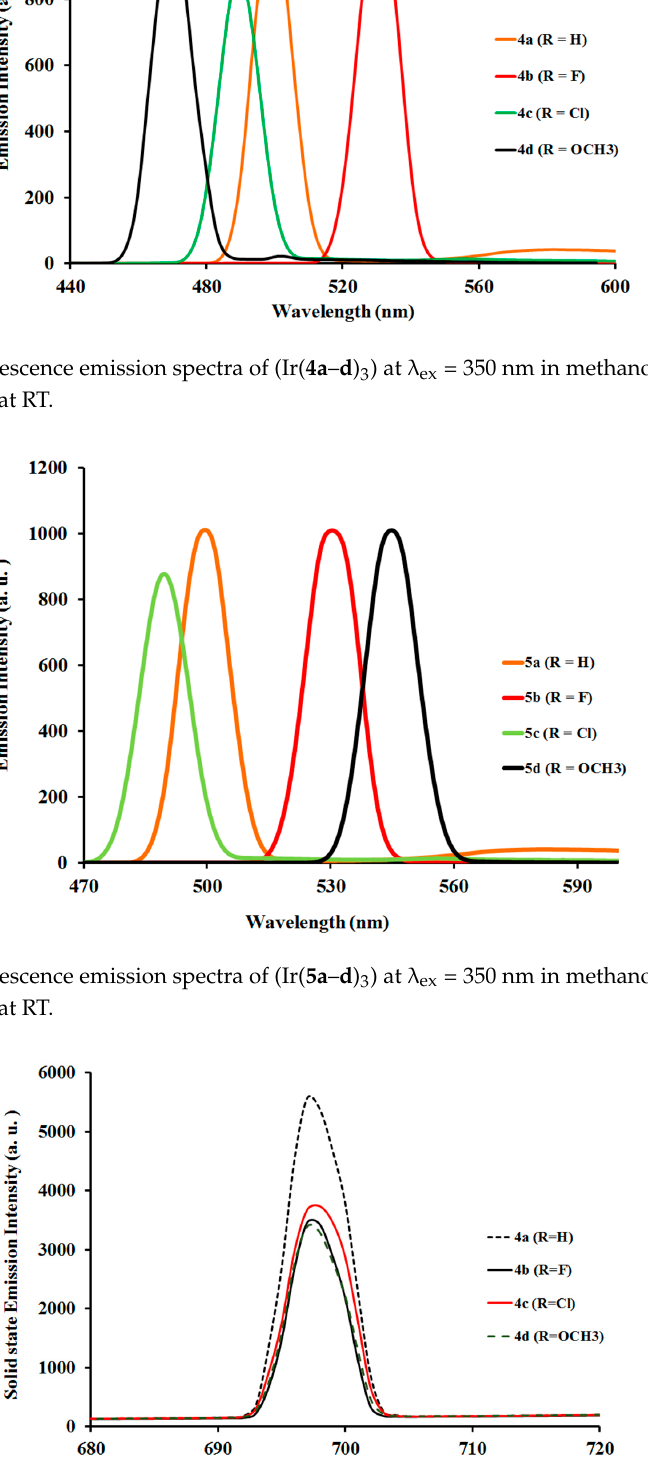
λ ex = 350 nm at 3 ) at